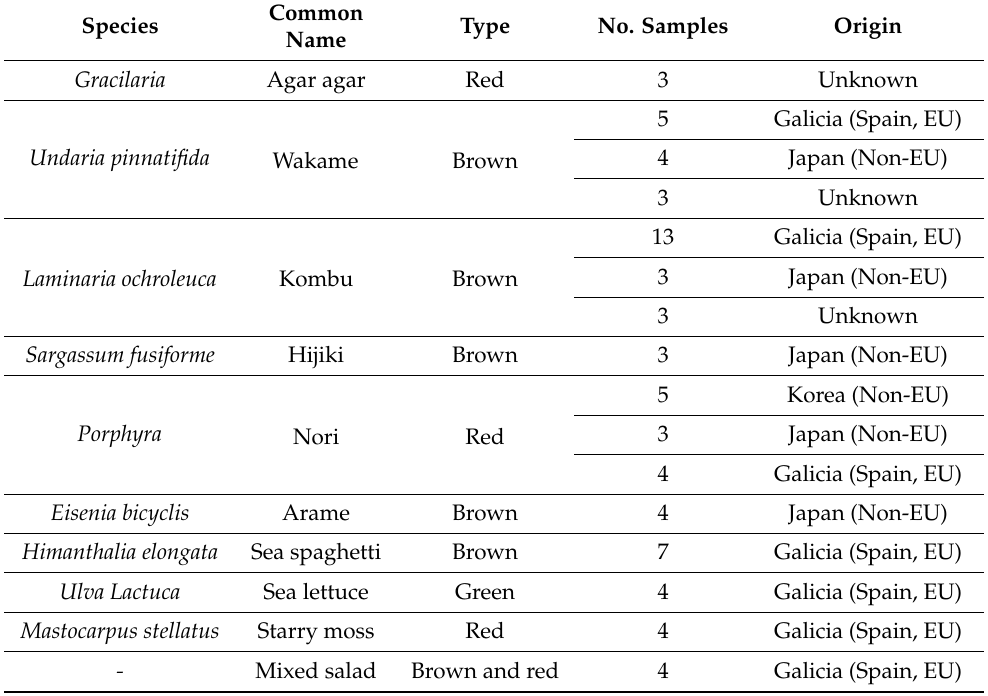
Table 1. Characteristics of the analyzed algae samples.